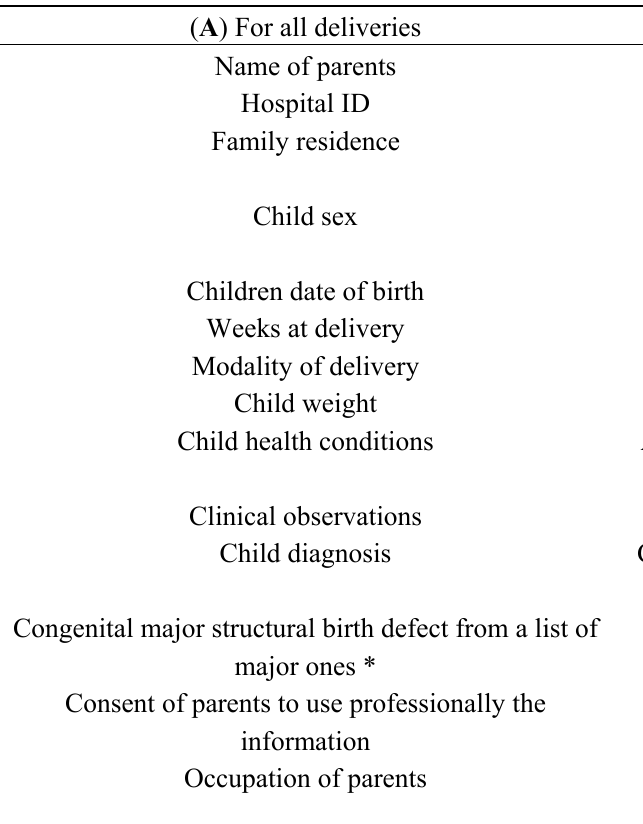
Table 1. Summary of the question asked during registration of the births in delivery room. * confirmation of the diagnosis was received by the Doctors in the Intensive Care Unit. ( A ) Section for all deliveries; ( B ) Section for deliveries with BD, premature and still births, and late